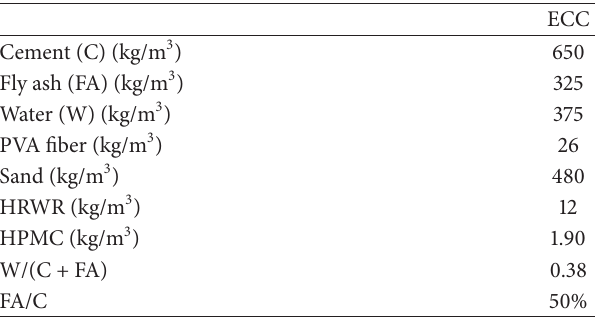
Table 1: Mixture properties of ECC. Table 2: Two cooling regimes for different curing age ECC speci- mens.